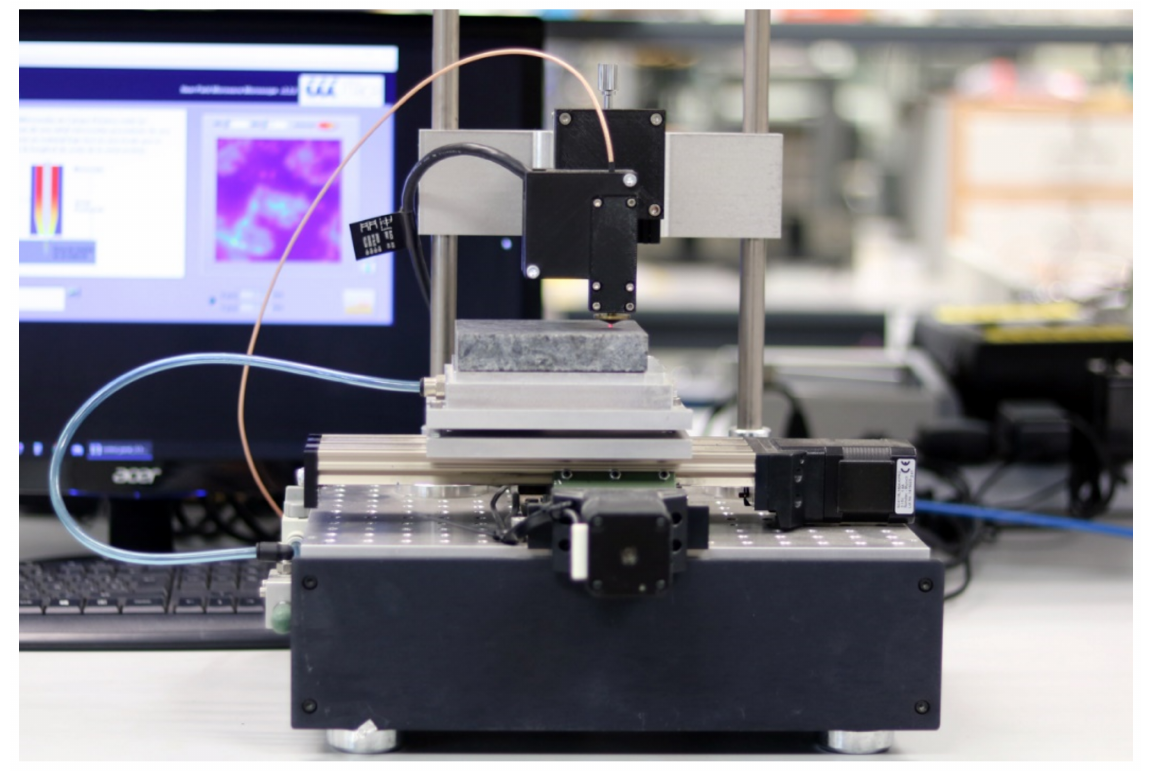
Figure 2. The near-field microwave microscope